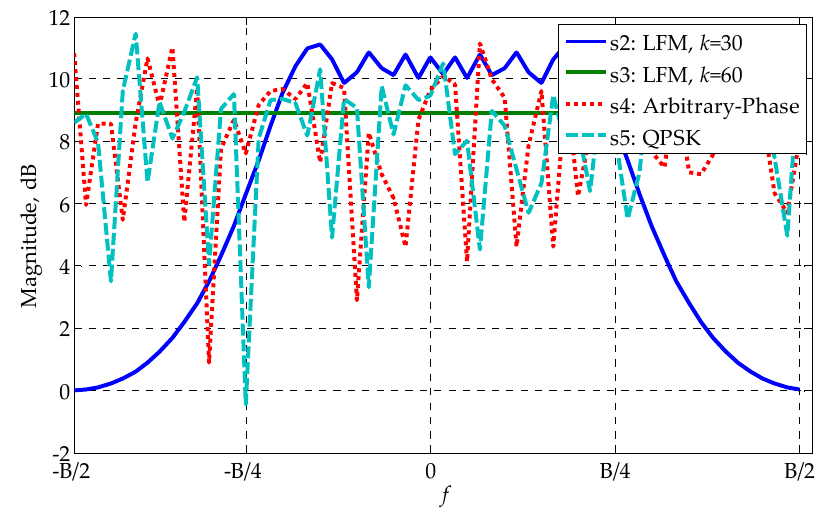
Figure 2. CRB versus SNR for different waveforms in the white noise.